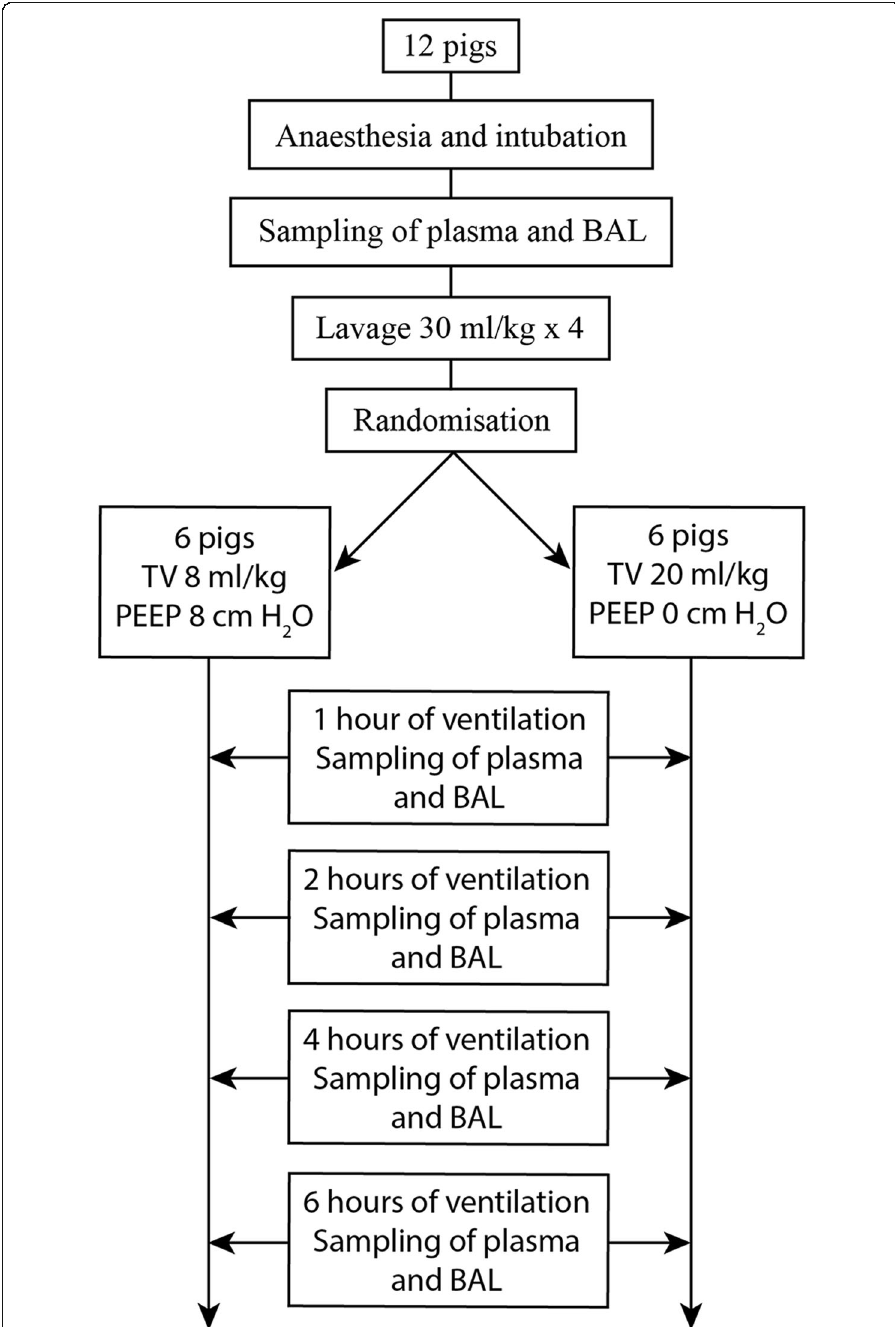
Fig. 1 Schematic overview of the protocol. BAL bronchoalveolar lavage, TV tidal volume, PEEP positive end-expiratory